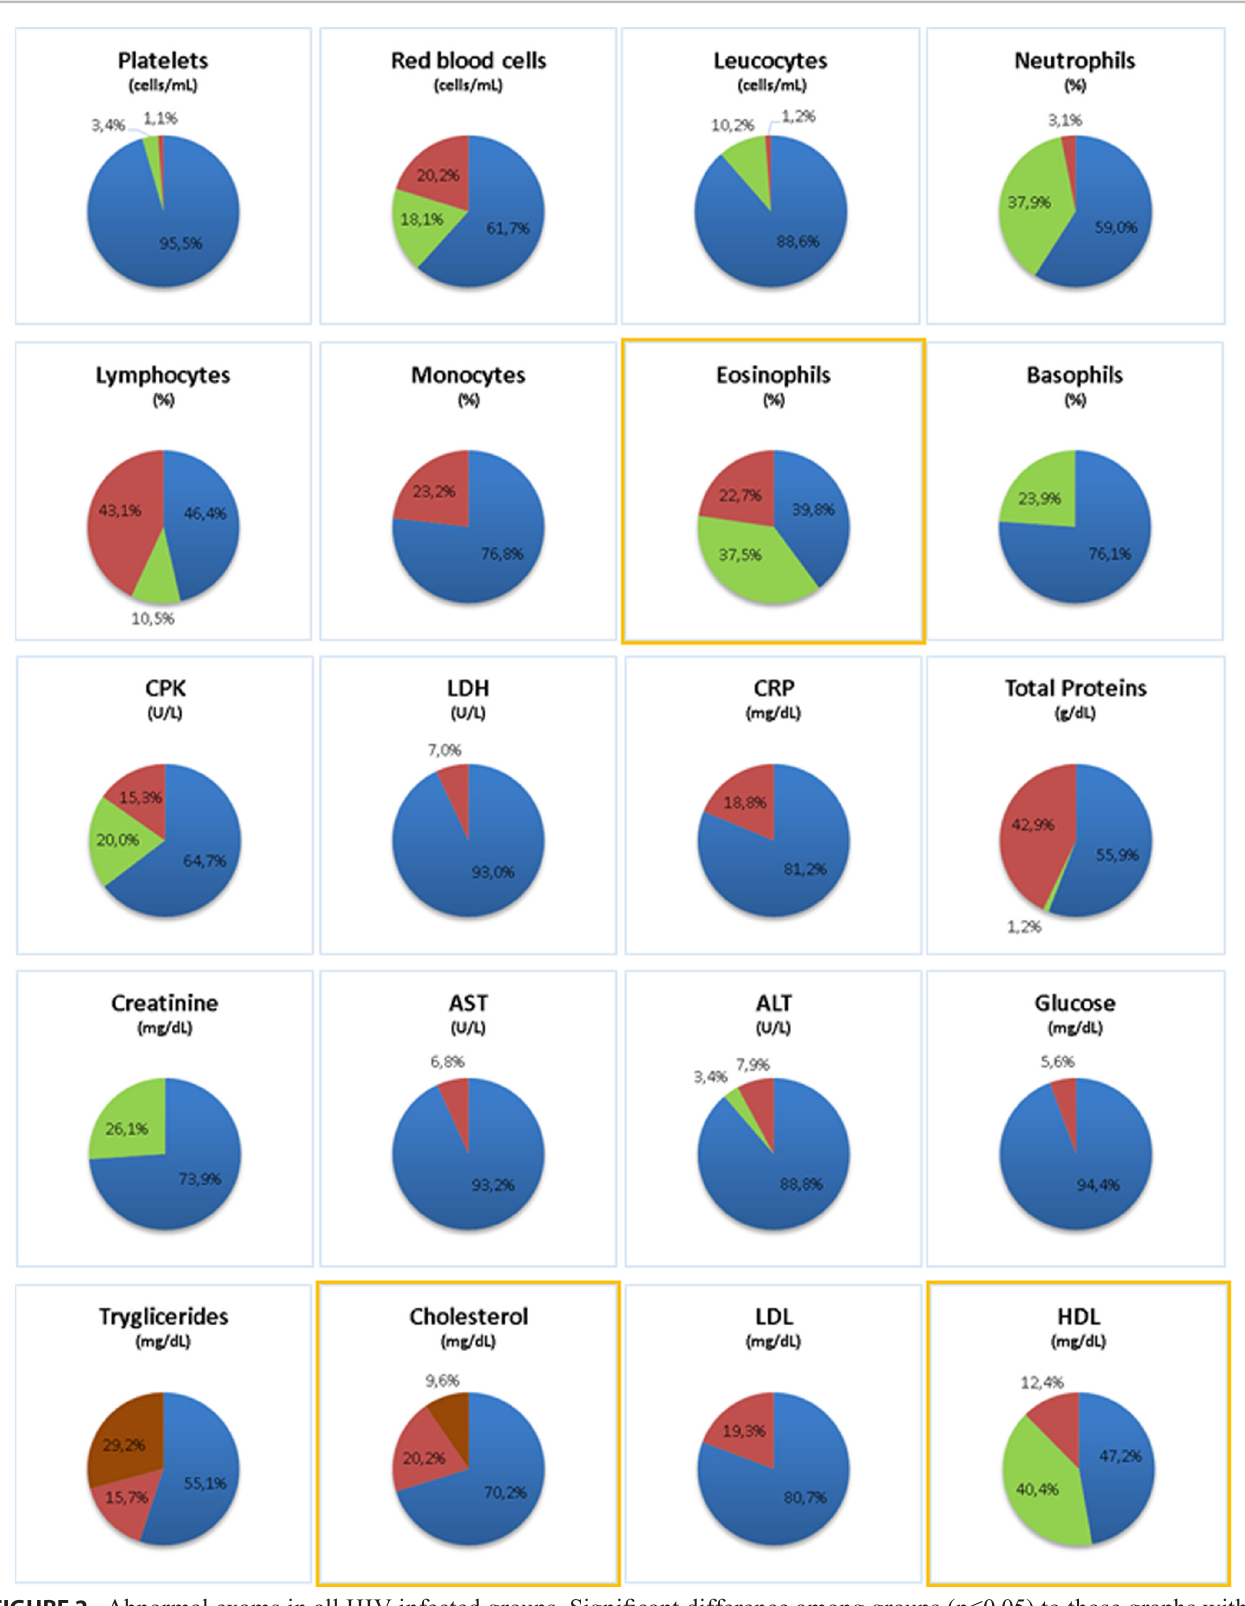
FIGURE 2 - Abnormal exams in all HIV-infected groups. Significant difference among groups (p≤0,05) to those graphs with a yellow board. Qui-square was used for all variables studied. Normal results in blue; Low values in green; High values in red; Very high values in